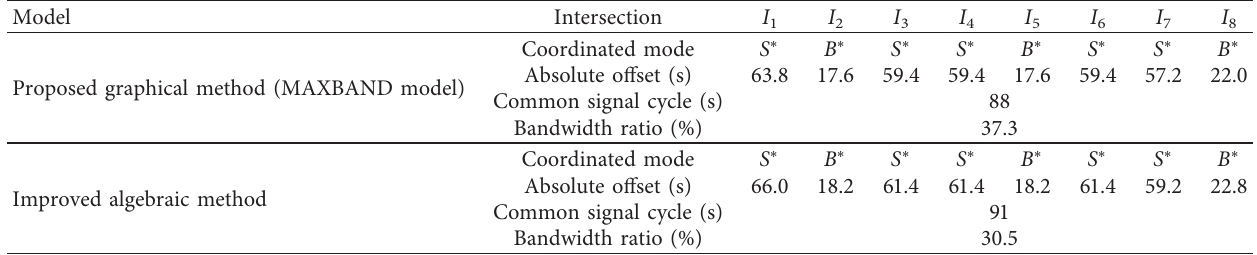
Table 2: The comparison table of the coordination effects of various models.